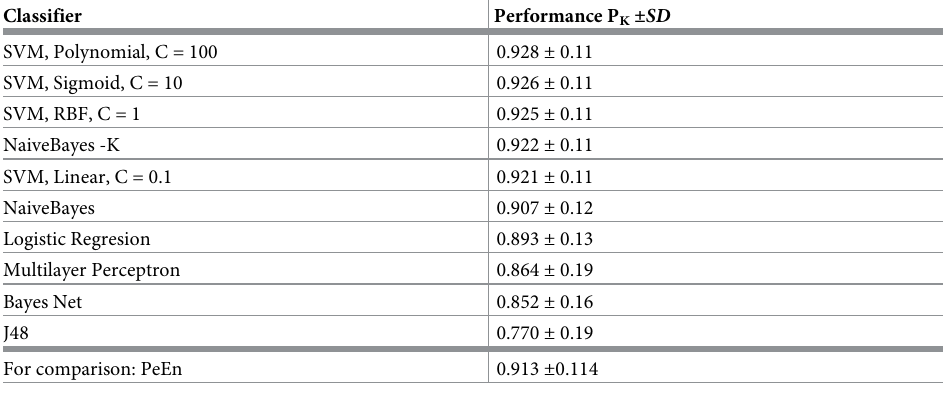
Table 2. Performance of the learning algorithms on data sets with the 10 parameters with the highest information gain. The single parameter with the highest PK value, permutation entropy, is given for